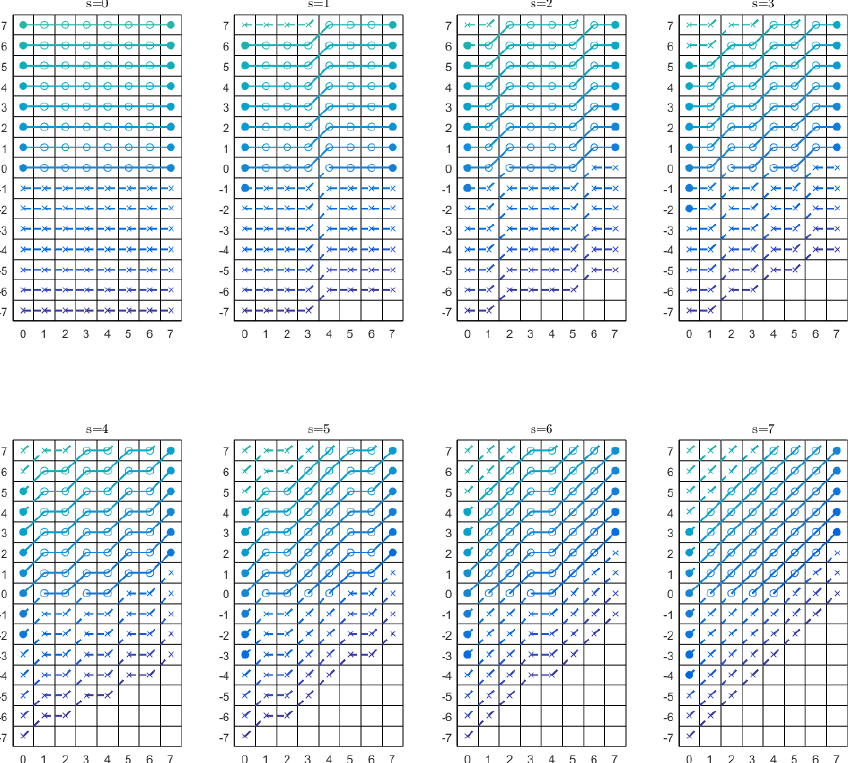
Figure 9. A depiction of the whole set of discrete lines covering the displacements and slopes, as computed by central